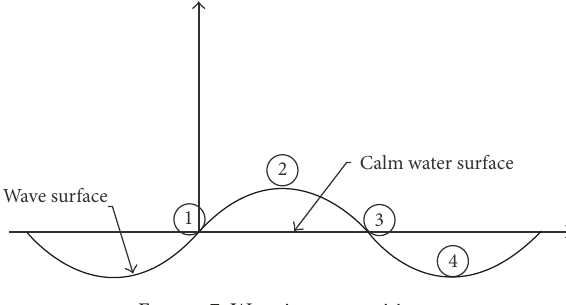
Figure 7: Wave impact